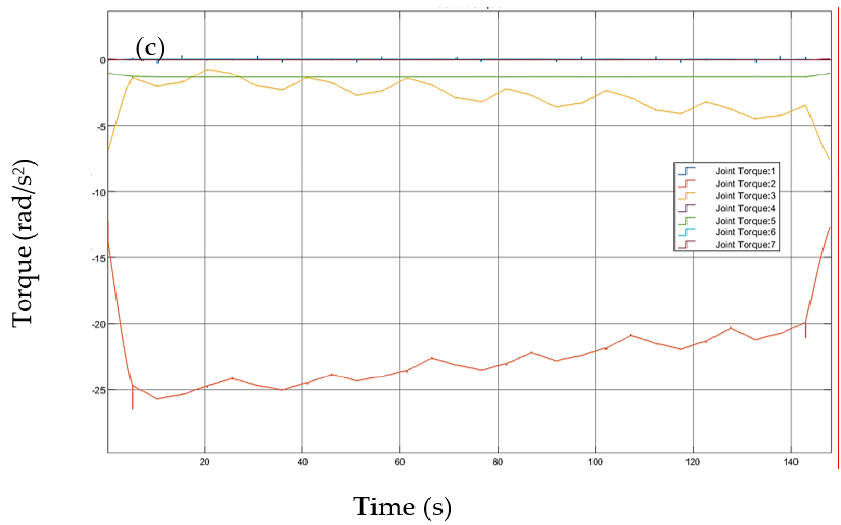
Figure 8. The results of Simulink simulation: ( a ) joint angular velocity vs. time, ( b ) joint acceleration vs. time, ( c ) joint torque vs. time.